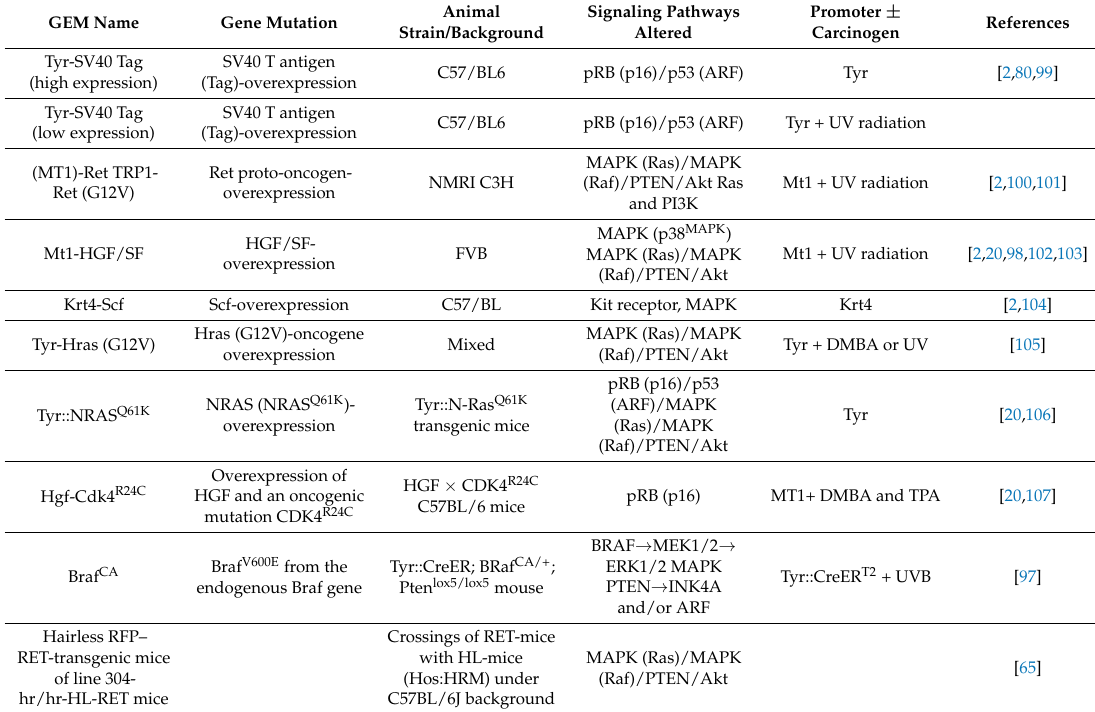
Table 2. Representative examples of genetic engineered mouse (GEM) models of